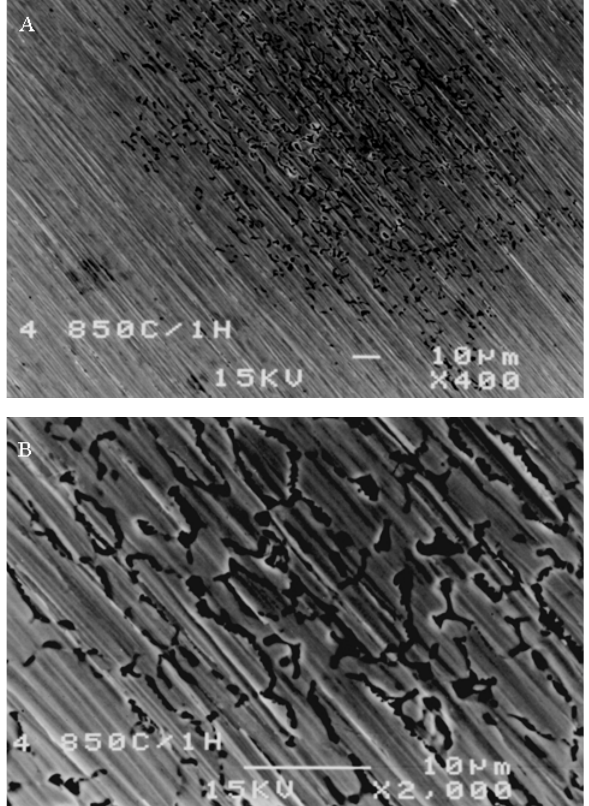
Figure 8. Corroded area of about 150 µ m (A) of the heat-treated UR45N alloy at 850 °C/1 h after the cyclic potentiodynamic test, which resembles an intergranular attack. SEM - secondary electrons image. 400X; (B) 2000X (detail of